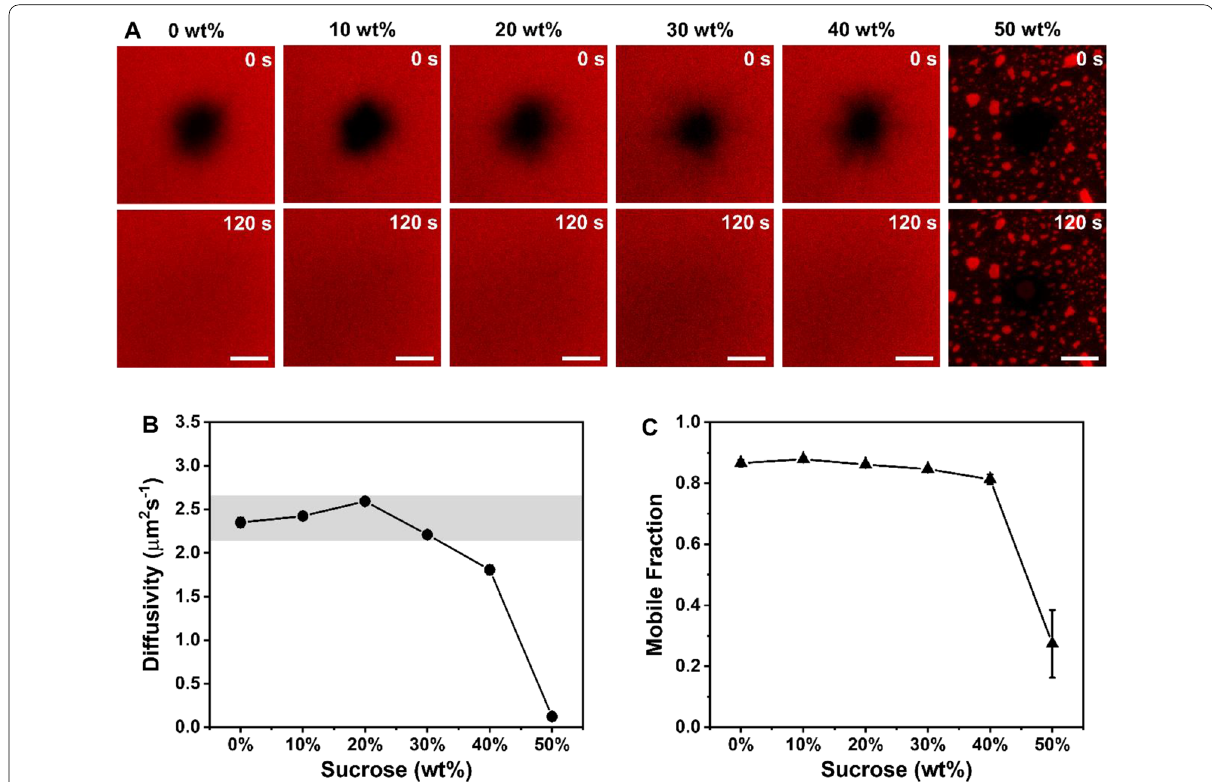
Fig. 3 Fluorescence recovery after photobleaching (FRAP) analysis for the mobility characterization of lipid bilayers in various sucrose concentrations. A The fluorescence micrographs at 0 s and 120 s after photobleaching; fluorescence recovery within the photobleached region in 0–50 wt% sucrose. Scale bars are 20 μm. B Diffusion coefficient values and C mobile fractions for the lipid membranes formed from 0 to 50 wt% sucrose–bicelle mixtures ( n 3, mean SD). The highlighted grey region in the graph of diffusivity values denotes typical values of a complete = ±